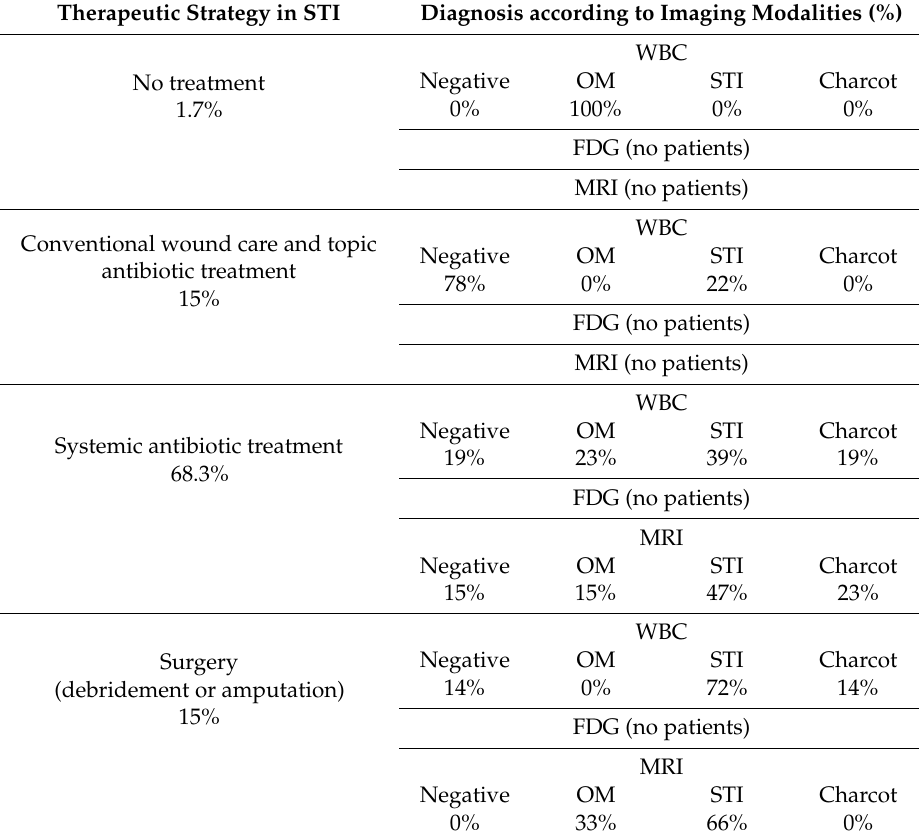
WBC Negative OM Charcot 0% 100% 0% FDG (no patients) MRI (no patients)